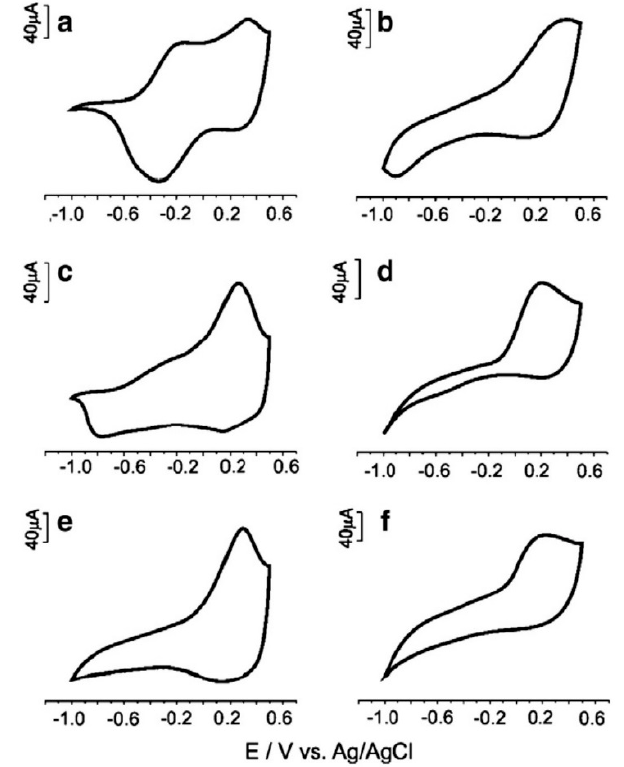
Figure 6. Cyclic voltammograms measured with the six working electrodes described in [65] in the same emulsion of extra virgin olive oil. ( a ) Ppy/FCN; ( b ) Ppy/MO; ( c ) Ppy/NP; ( d ) Ppy/AQS; ( e ) Ppy/H2SO4; ( f ) Ppy/PWA Reproduced with permission.